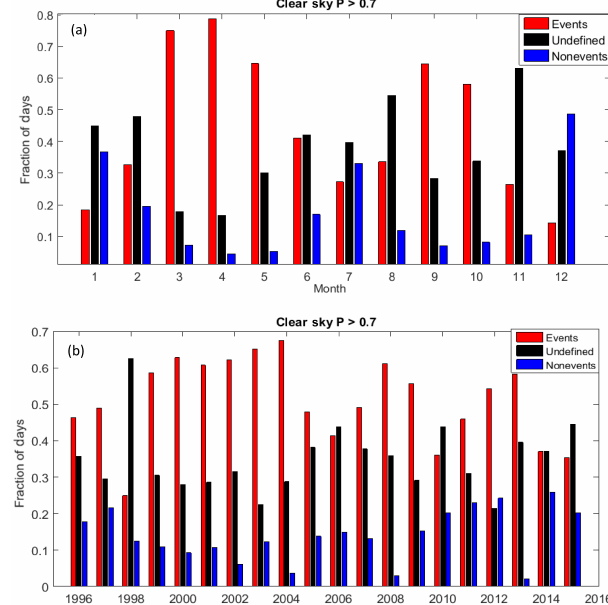
Figure 3. (a) Monthly and (b) yearly fraction of clear-sky days clas- sified as NPF events, undefined and nonevents. In 1998, global ra- diation data are limited to 5.4%, leading to the classification